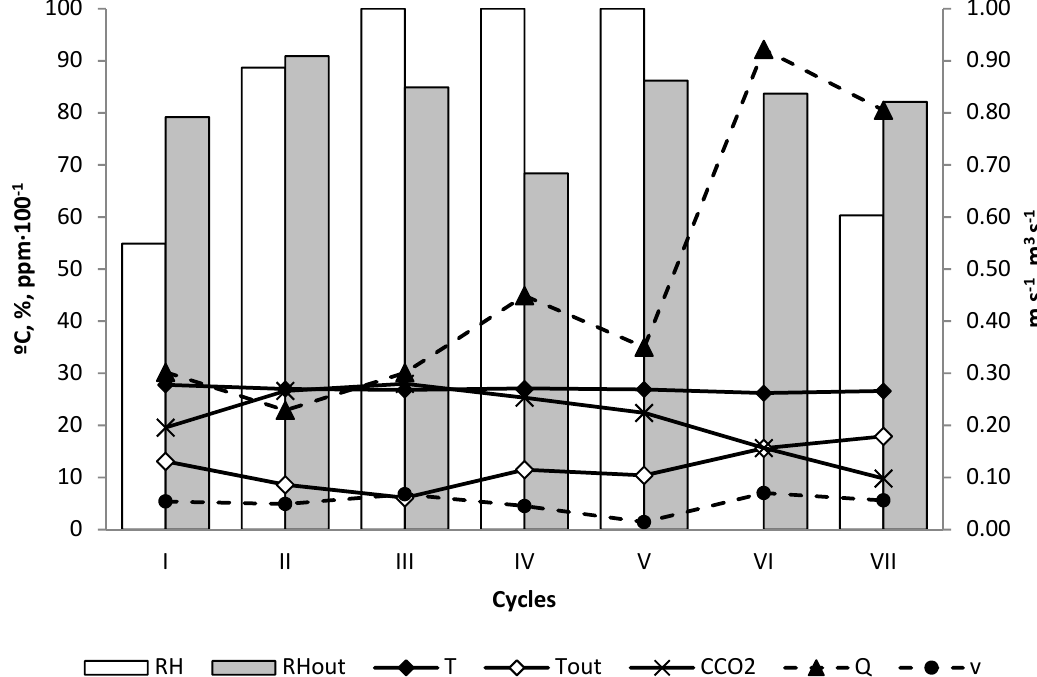
Figure 3. Environmental variables for each cycle. RH: Average relative humidity in the animal zone (%), RH out : Average outdoor relative humidity (%), T: Average temperature in the animal zone (°C), T out : Average outdoor temperature (°C), C CO2 : Average CO 2 concentrations in the animal zone (ppm · 100 − 1 ), Q: Average flow extracted with the fan (m 3 s − 1 ), v: Average air velocity in the animal zone (m s − 1